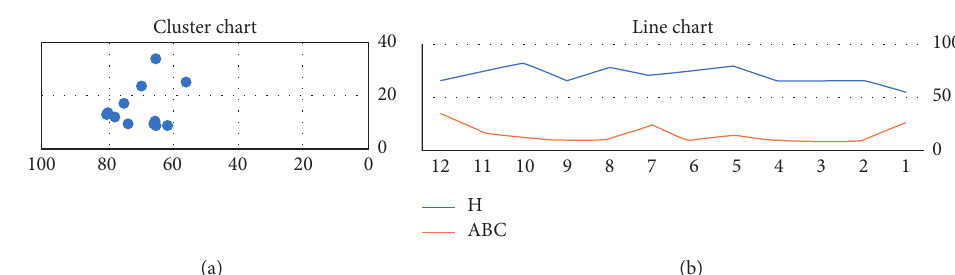
Figure 2: Cluster and line chart of R and H.